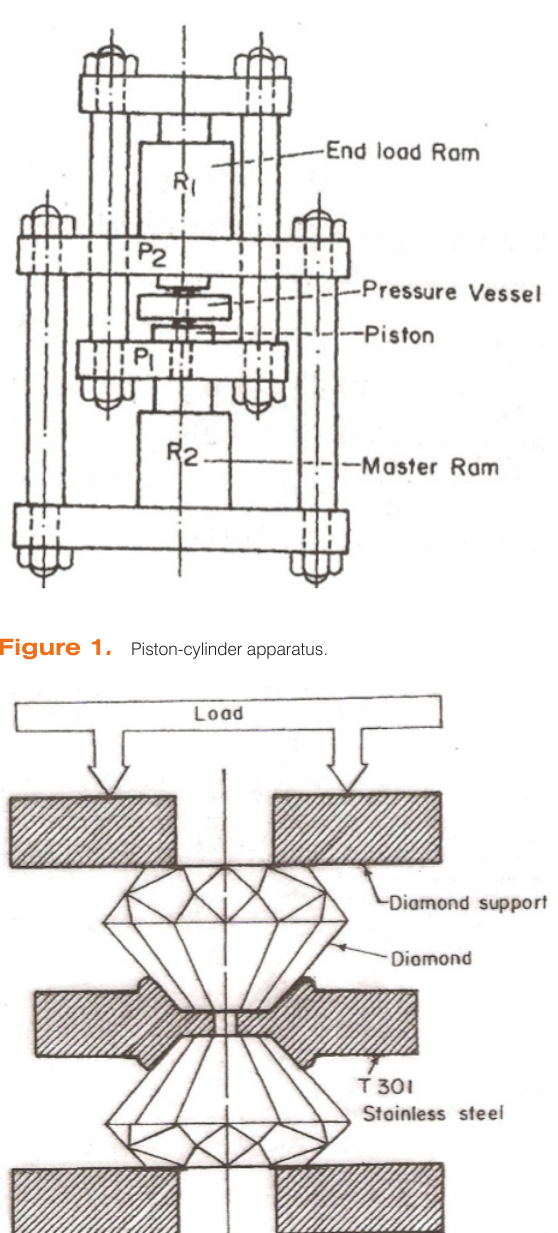
Figure 2. Opened diamond anvil cell configurations with a metal gasket for sample confinement in a pressure